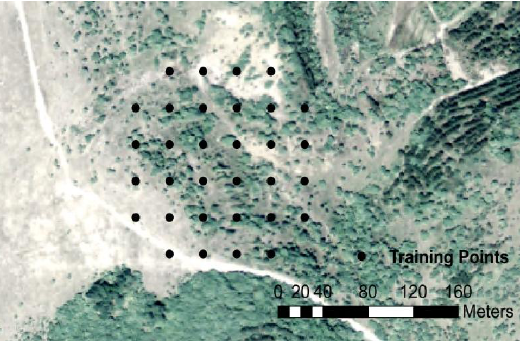
Figure 2. An example of a maplet which shows relative size of training points to autumn olive